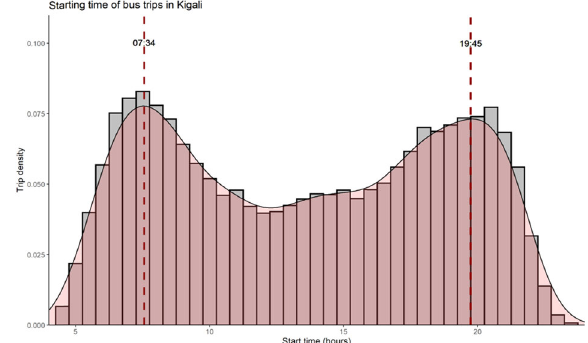
Fig. 2 Distribution of trip commencement times. Source: Own representation, GoMetro Ltd.